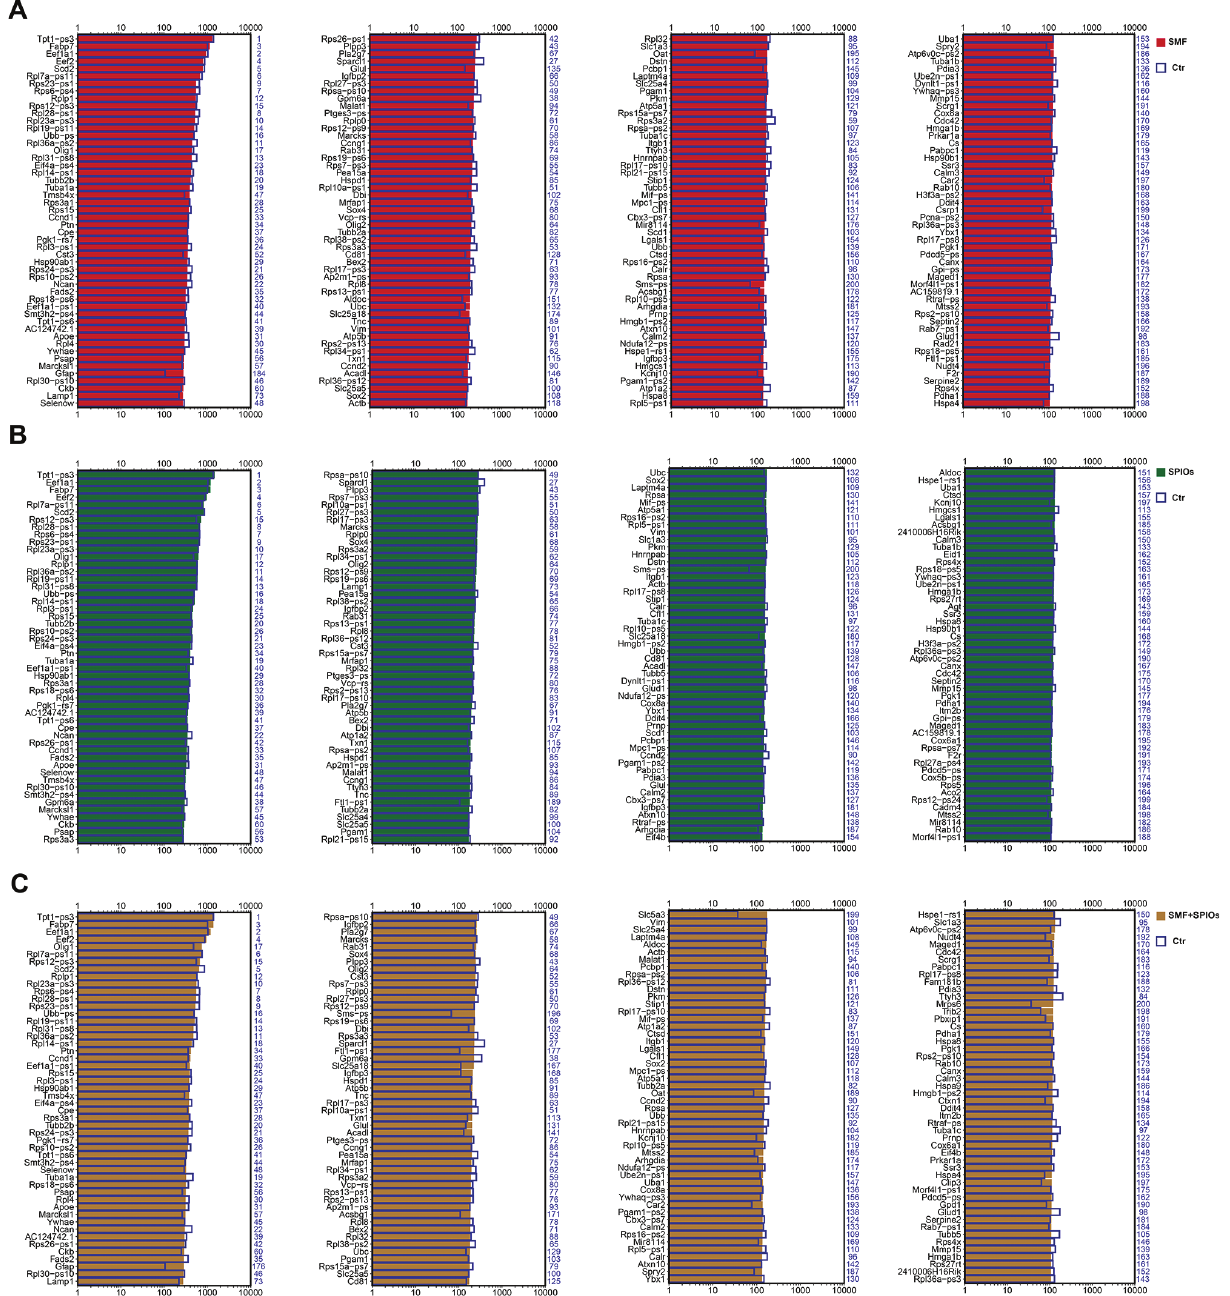
Fig. 2. Highly expressed genes in different groups. The top 200 highly expressed genes of the SMF group (red bar) (A), SPIOs group (green bar) (B), the SMF+SPIOs group ranked in descending order (yellow bar) (C). The number in blue on the right side of each panel represents the same gene ranking in the control